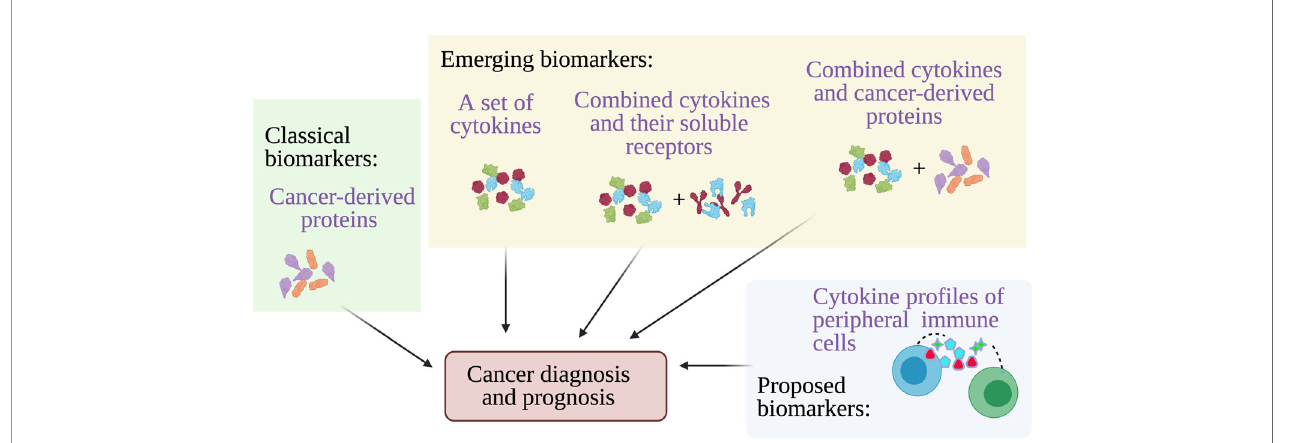
FIGURE 2 | Cytokines for cancer diagnosis and prognosis. Multiple cancer-derived proteins have been established and used at clinics as biomarkers to detect cancer from blood, however other approaches including detection of a set of cytokines, combining cytokines and their soluble receptors, and combining cytokines and cancer proteins may provide better accuracy for cancer diagnosis and prognosis. A highly accurate alternative cancer biomarkers have been proposed which is the cytokine secretion pro fi le of the circulating peripheral immune